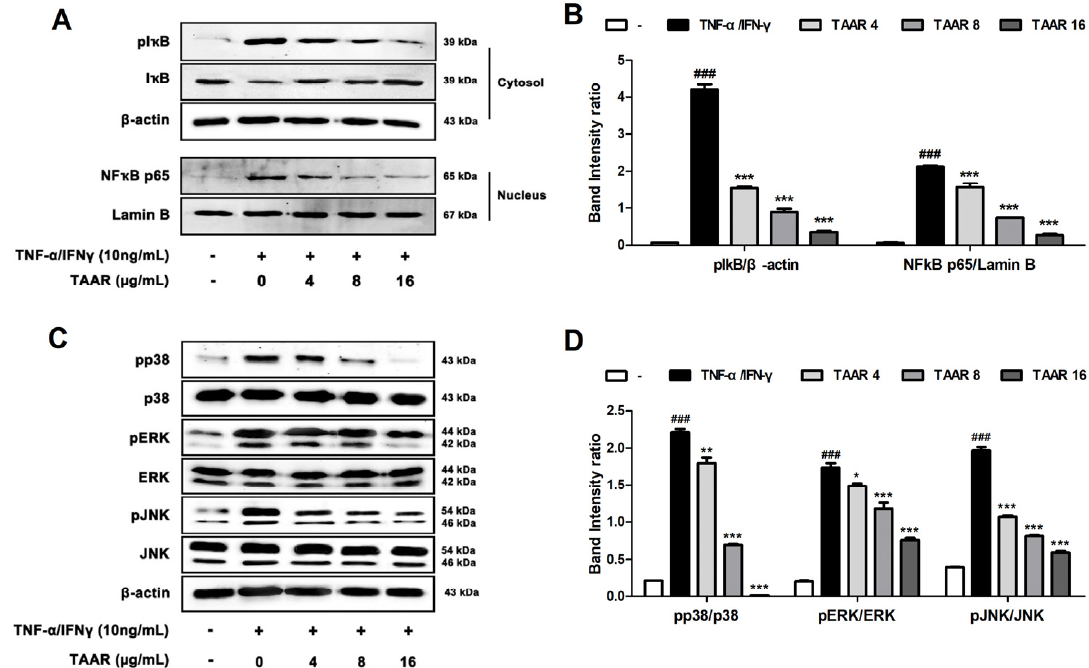
Figure 4. Effects of TAAR extract on the NF κ B and MAPK signaling pathways in TNF- α /IFN- γ - induced HaCaT cells. ( A ) Protein levels of cytosol I κ B and nucleus NF κ B. ( B ) Bar graph showing the relative density of the Western blot band pI κ B/ β -actin and NF κ B/lamin B. ( C ) Protein expression levels of phosphorylated and total MAPKs (p38, ERK, and JNK). ( D ) Bar graph showing the relative density of the Western blot band pp38/p38, pERK/ERK, and pJNK/JNK. All values are presented as the mean ± SEM of three experiments. Data were analyzed by Tukey’s post hoc test. ### p < 0.001 vs. no treatment group; * p < 0.05, ** p < 0.01, and *** p < 0.001 vs. TNF- α /IFN- γ treatment only group.